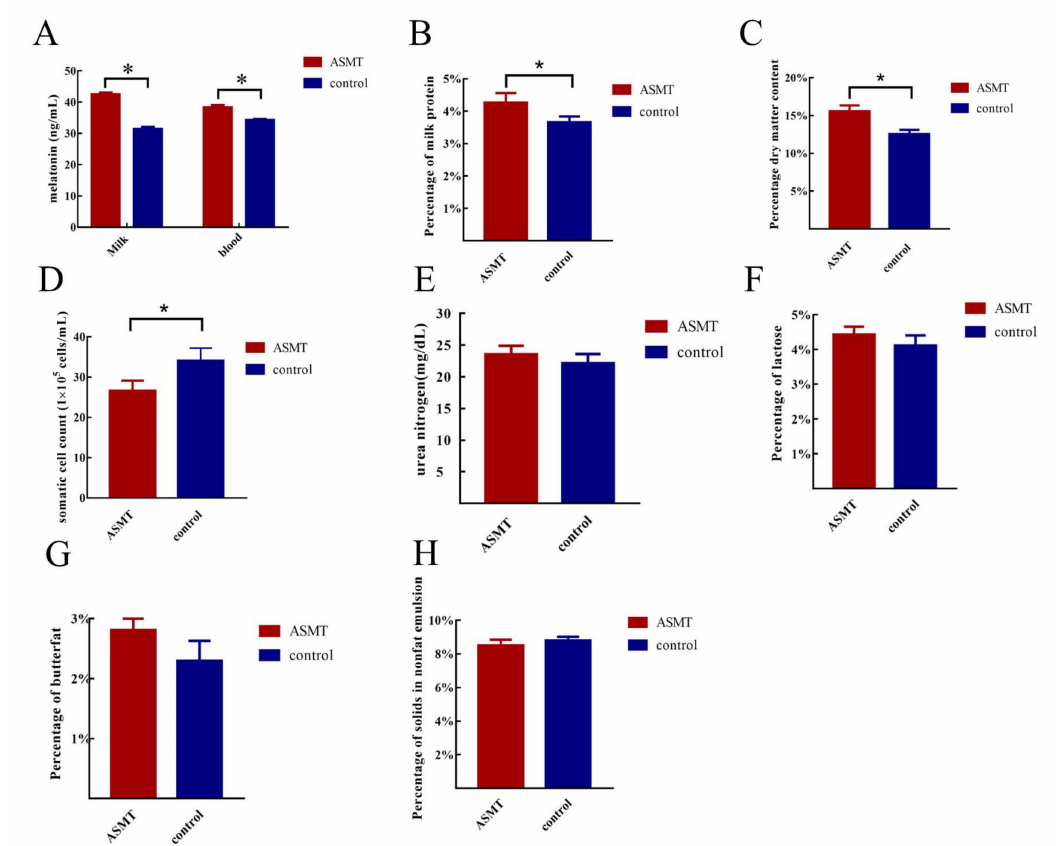
Figure 3. Comparisons of the melatonin levels in blood and milk as well as the milk parameters between transgenic (ASMT) and WT goats. ( A ) Melatonin levels in the blood and milk; ( B ) protein content in milk; ( C ) dry matter content in milk; ( D ) somatic cell count in milk; ( E ) urea nitrogen in milk; ( F ) lactose content in milk; ( G ) fat in milk; ( H ) non-lipid solids in milk. Note: the transgenic goat ( n = 3), wild type ( n = 3), * represents significant differences between the two